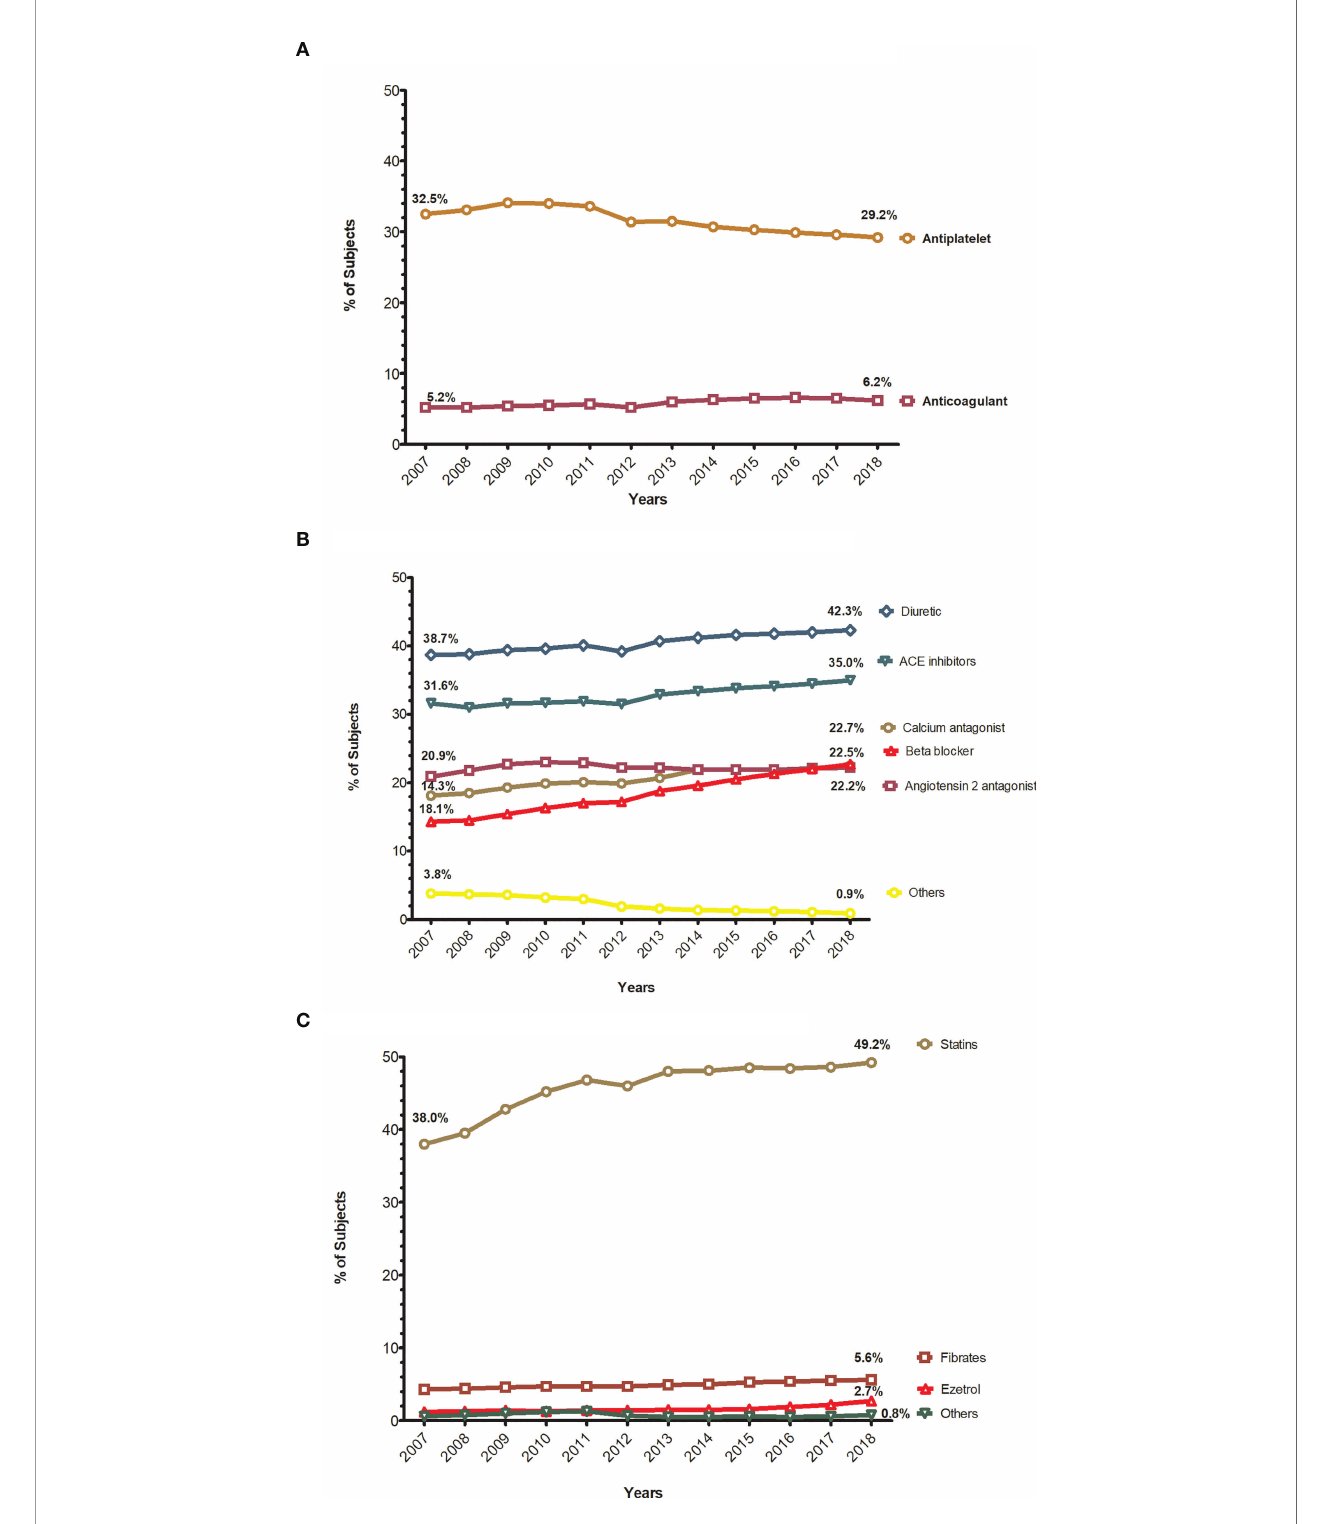
FIGURE 3 | Trends in the proportion of subjects treated with antithrombotic, antihypertensive, and lipid-lowering drugs. (A) Annual trends in the proportion of subjects treated with antithrombotic drugs. (B) Annual trends in the proportion of subjects treated with antihypertensive drugs. (C) Annual trends in the proportion of subjects treated with lipid lowering